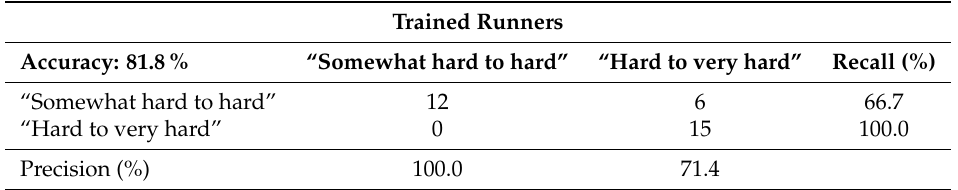
Table 6. Confusion matrix for the CNN classifiers in the trained runner setting. Each row represents the correct label (e.g., ground truth), whereas the columns display the predictions made by the network. Trained Runners Accuracy: 81.8% “Somewhat hard to hard” “Hard to very hard” Recall (%) “Somewhat hard to hard” 12 6 66.7 “Hard to very hard” 0 15 100.0 Precision (%) 100.0